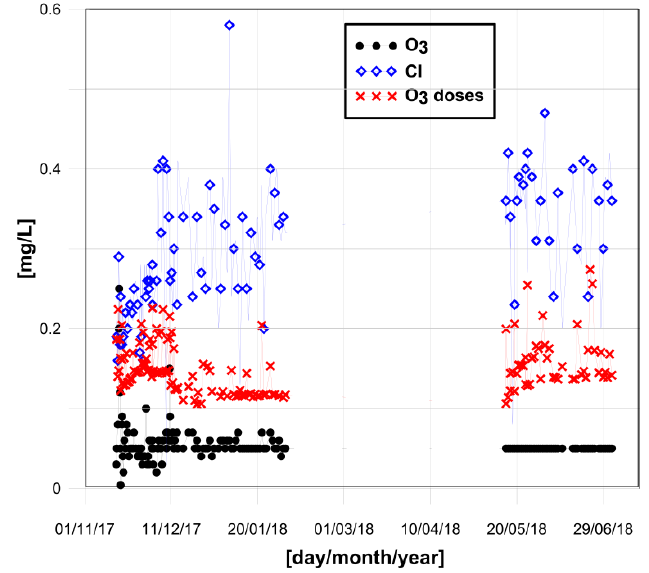
Figure 3. Chlorine and ozone concentration in water after disinfection.